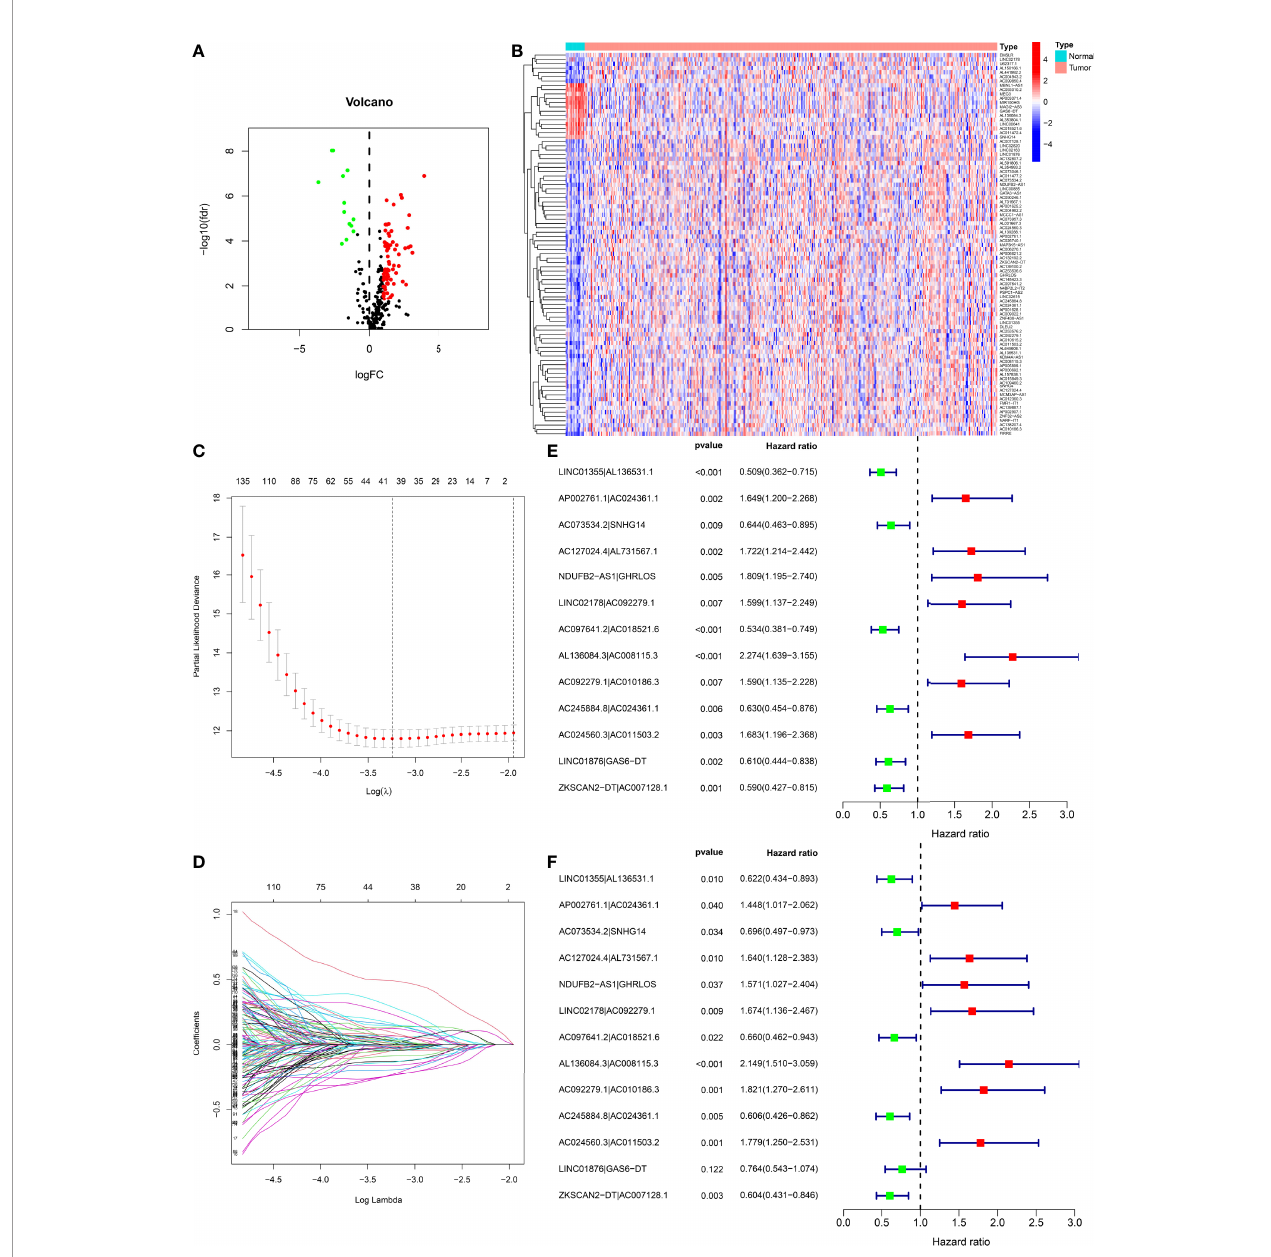
FIGURE 2 | Development of a risk model with DEnrlncRNA pairs. (A) The volcano plot of necroptosis-related lncRNAs. (B) The heatmap of necroptosis-related lncRNAs between BLCA and normal tissues. (C) LASSO coef fi cient distribution of 13 necroptosis-related lncRNAs. (D) Ten-fold cross-validation for variable selection in LASSO models. (E) A forest map revealing 13 DEirlncRNA pairs detected using univariate Cox regression analyses. (F) A forest map revealing 13 DEirlncRNA pairs detected using multivariate Cox regression